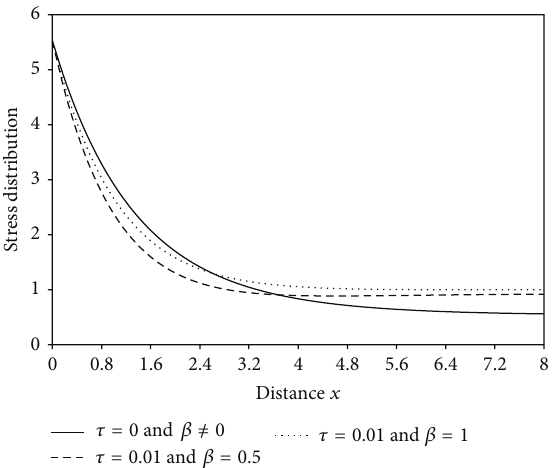
Figure 2: Profile of stress